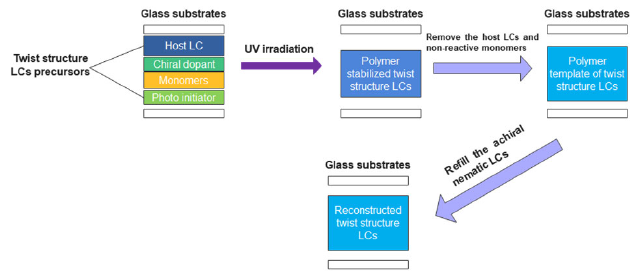
Figure 2. Schematic of templating process for fabricating the TSLCs templates.